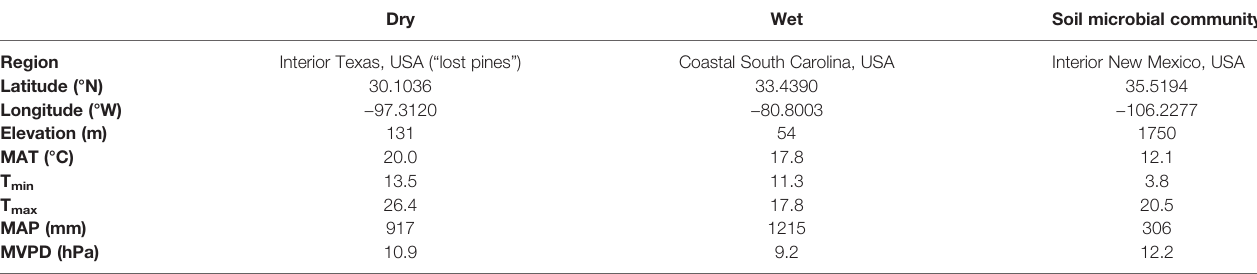
TABLE 1 | Location and climate information (1960 – 2017) for the dry and wet families and the drought-adapted soil microbial community used for inoculation treatment.